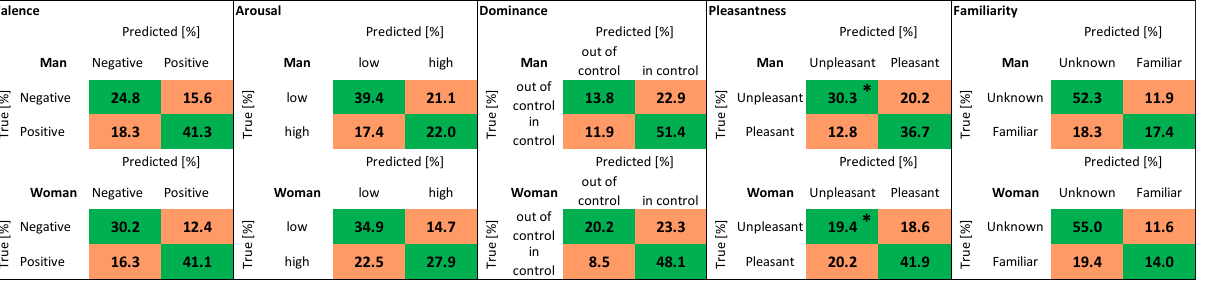
Figure 14. Confusion matrices. Values distributed into the two classes: Man, Woman. Classification obtained with: KNN algorithm, PRV + SP features, LOSO cross-validation. The values marked with one asterisk, in the box relating to the Pleasantness variable, are significantly different (Mann – Whit- ney test, two-tailed, based on the values that refer to each volunteer). P = 0.038.